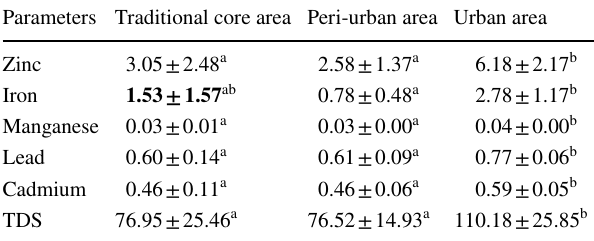
Table 5 ANOVA result for analyzed parameters based on residential location